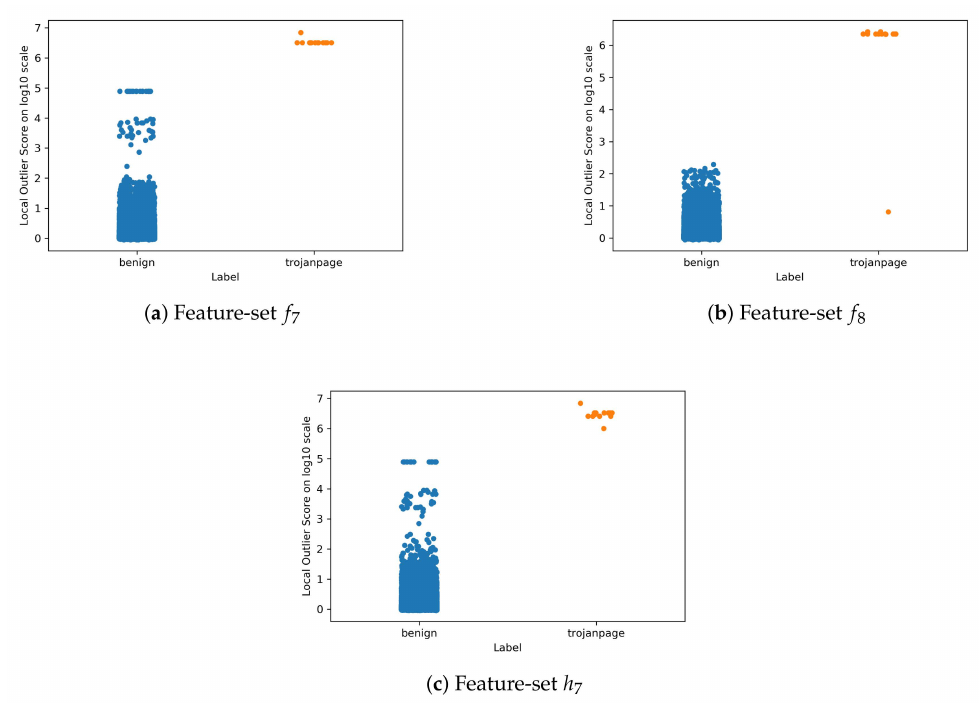
Figure 12. Local outlier score values for different features on dataset A for the attack TrojanPage